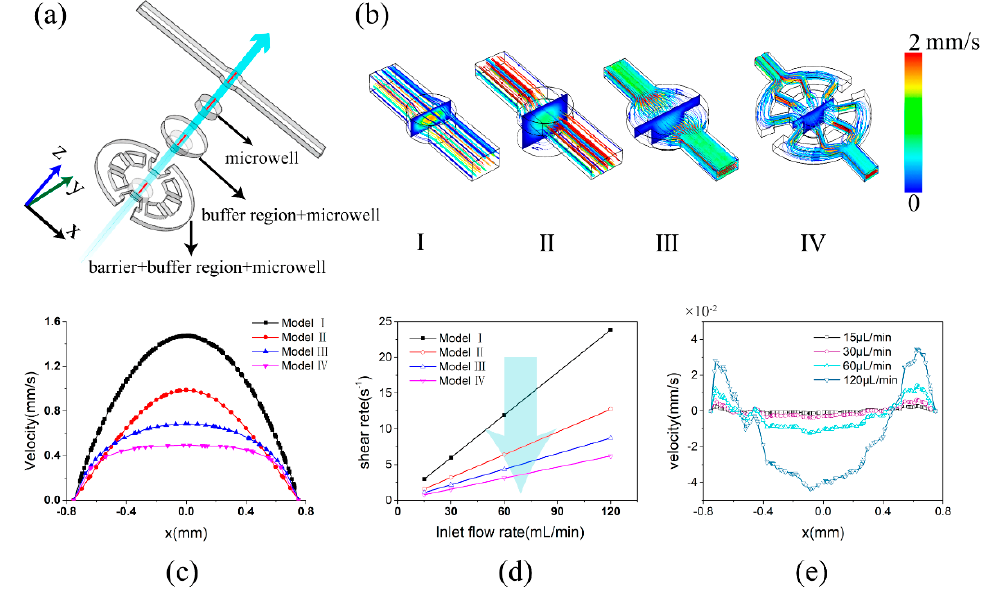
Figure 2. 3D flow characteristics in the coral culture chip channel with a constant perfusion flow-rate. ( a ) The di ff erent design models (I, II, III, IV) for the coral culture. ( b ) The flow field profiles of the four models with the inlet flow rate of Q = 30 µ L/min. Flow velocity gradients were indicated by colors ranging from 0 (blue) to 2 mm / s (red). ( c ) The flow velocities along the x -axis passing through the center of the coral culture chip as the red lines marked in ( b ). ( d ) The mean shear rates in the red line regions at various simulation inlet flow rates for the four models. ( e ) The flow velocity profiles of the red line regions along the z -axis at various inlet flow rates for the model ΙV .